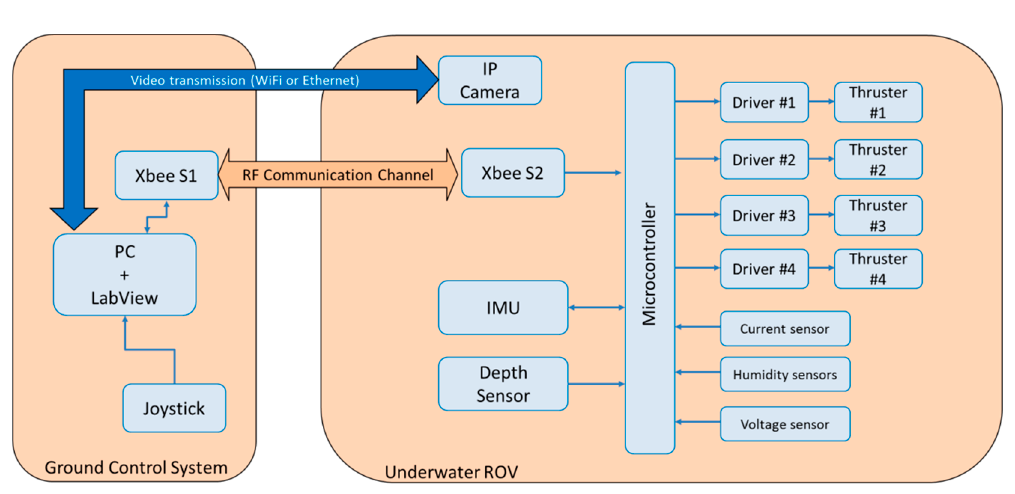
Figure 4. ROV electronic architecture.